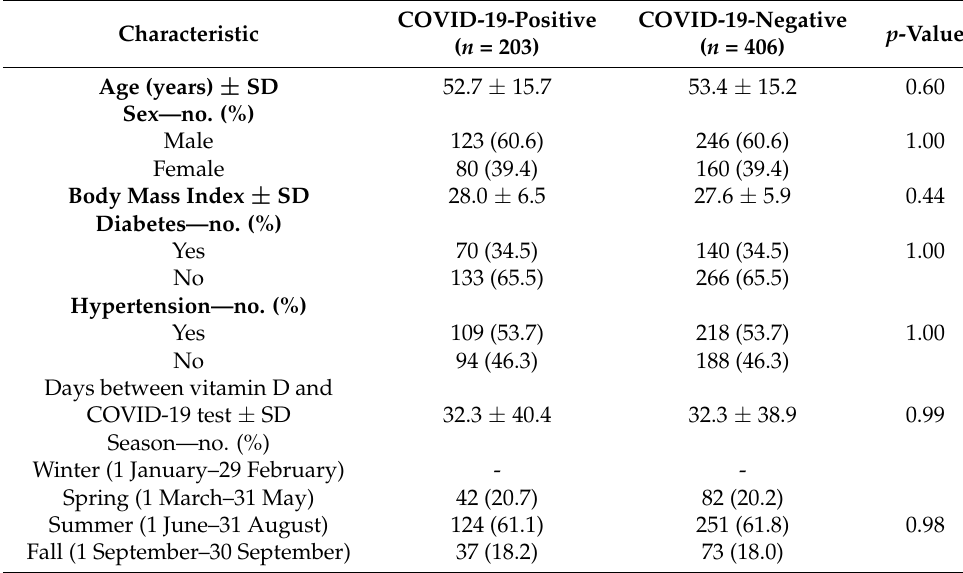
Table 2. Characteristics of the COVID-19 study population and controls: serum 25(OH)D measured after COVID-19 diagnosis.